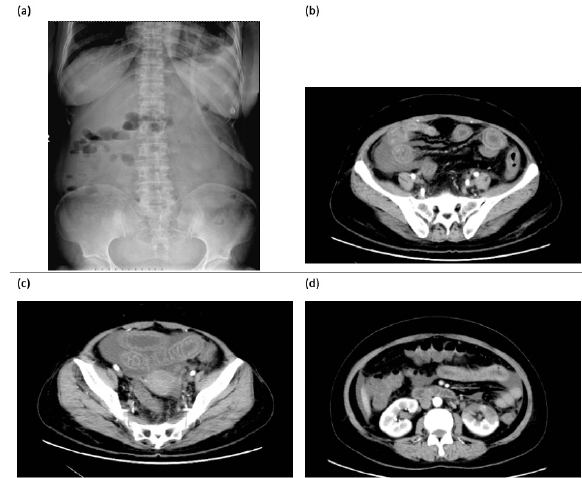
Figure 1: Plain radiograph showed dilated loops of small bowel with multiple air-fluid levels. (b,c,d) abdominal enhanced CT revealed intestinal vascular loop-like enhancement, intestinal dilatation indicating ileus, effusion in thoracic cavity, abdominal cavity and pelvic cavity.